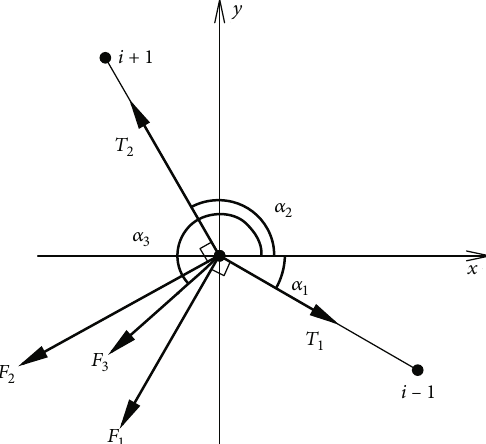
Figure 3: Force analysis diagram of the elastic membrane at the de fl ated state.